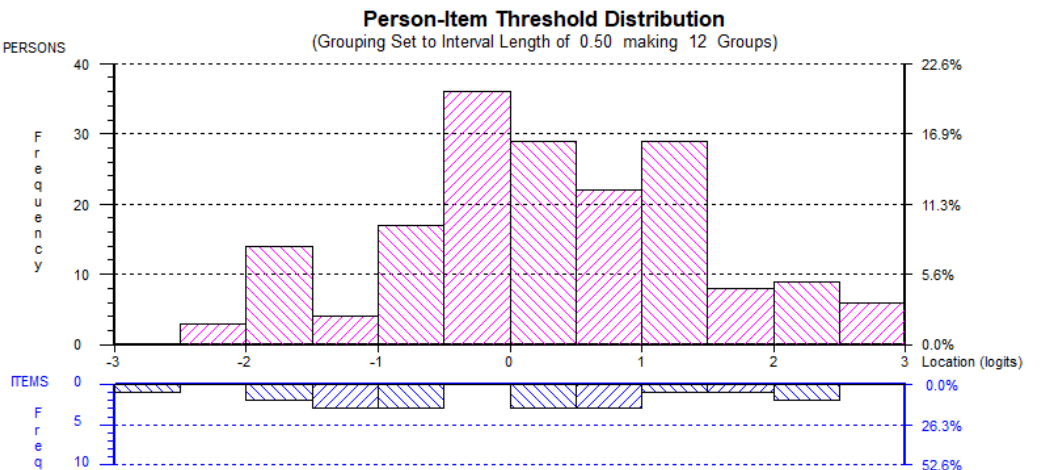
Figure 5. IMT rs Person-item distribution.